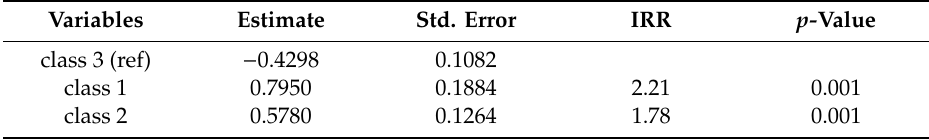
Table 2. Multivariate regression analysis of the link between malaria and risk